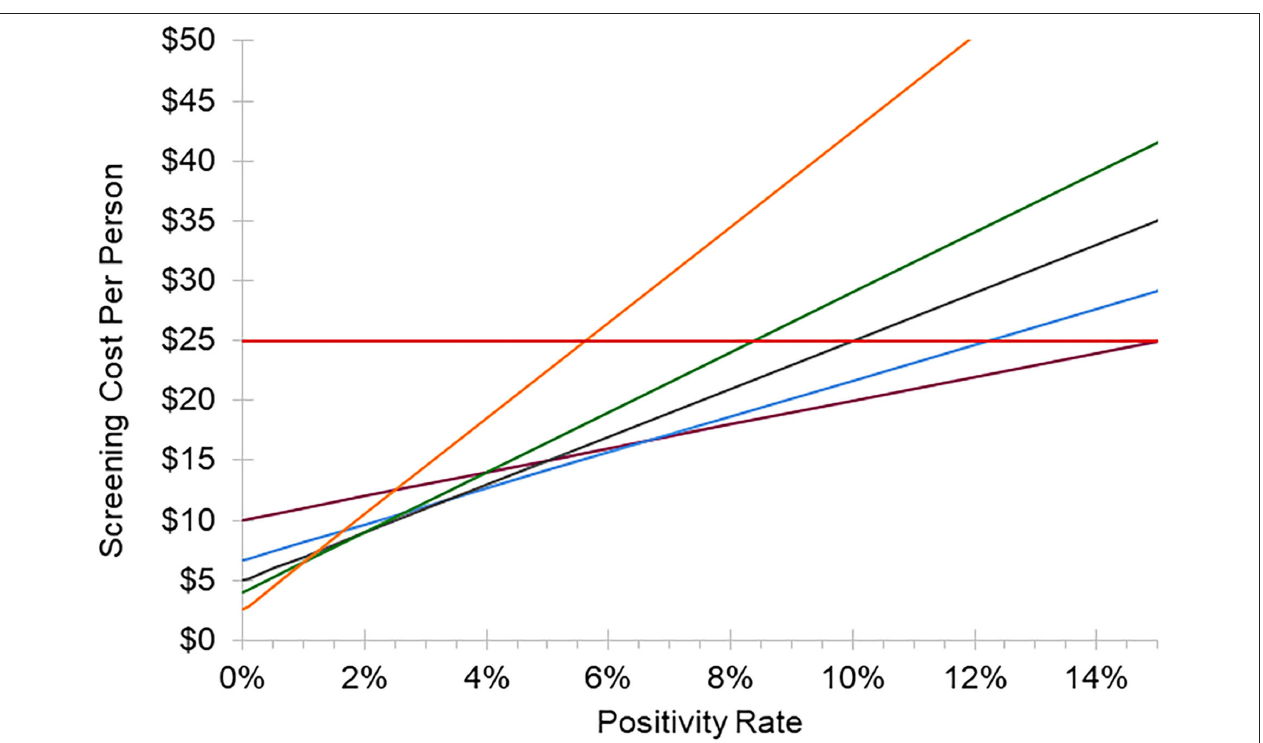
FIGURE 1 | Cost of individual vs. pooled testing. Cost per person of testing as a function of the percent positivity of the population tested. This model assumes an individual test cost of $25 and a pooled test cost of $40 due to additional processing steps required. Red line: individual testing, maroon line: pool size of 4, blue line: pool size of 6, gray line: pool size of 8, green line: pool size of 10, orange line: pool size of 16. Equation for pooled testing: ($40/pool size) + (% positivity × pool size ×